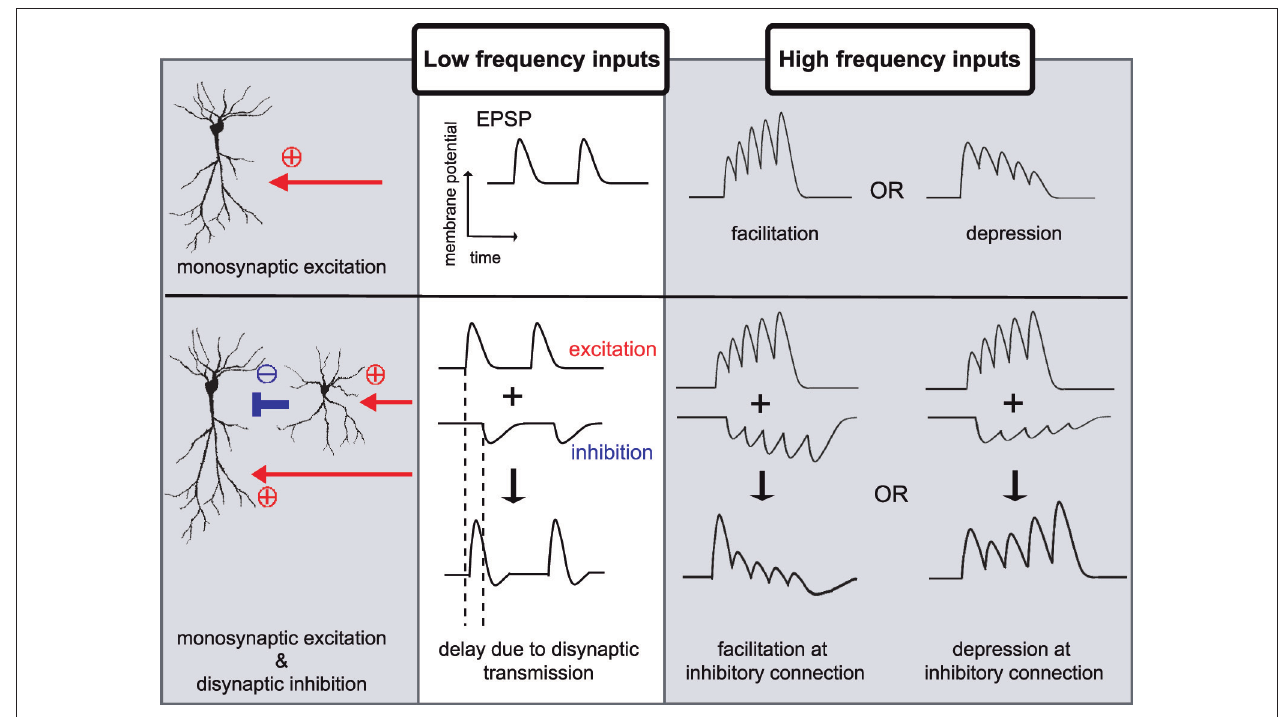
the temporal delay imposed by the additional synapse. During high frequency stimulation, however, disynaptic inhibition effectively influences monosynaptic excitation. Because each neuron shows distinct response to high frequency stimuli, disynaptic inhibitory connection shows facilitation, depression, or some characteristic response, which will, together with modulation in monosynaptic excitation, expand differential patterns of signal transmission between low and high frequency